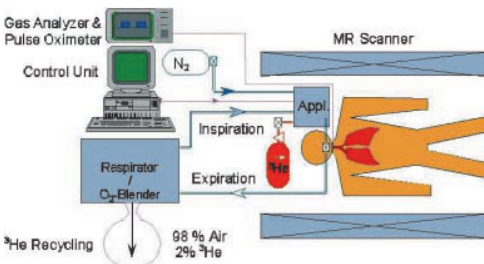
Setup for human 3 He MRI studies ( Appl : device for 3 He dosage and